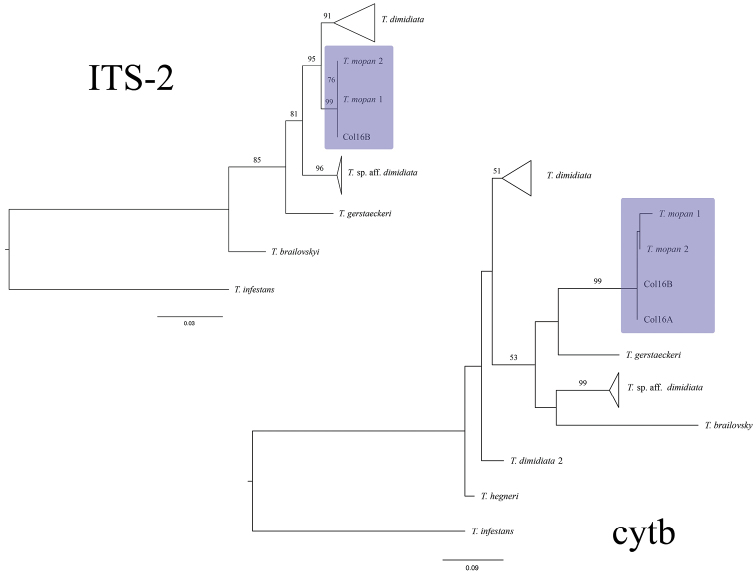
ML phylogenies reconstructed using ITS-2 (right) and cytb (left) sequences. Numbers above branches represent bootstrap support > 50. T.
mopan clade is highlighted in purple.